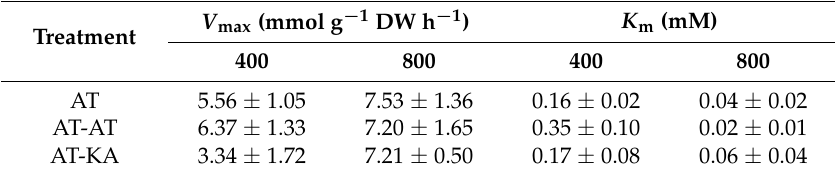
Table 2. Apparent V max and K m of net nitrate uptake for each treatment under medium (400 µmol PAR replicates ± SE. AT: Non-grafted treatment; AT-AT: Homograft; and, AT-KA: Graft treatment. Treatment